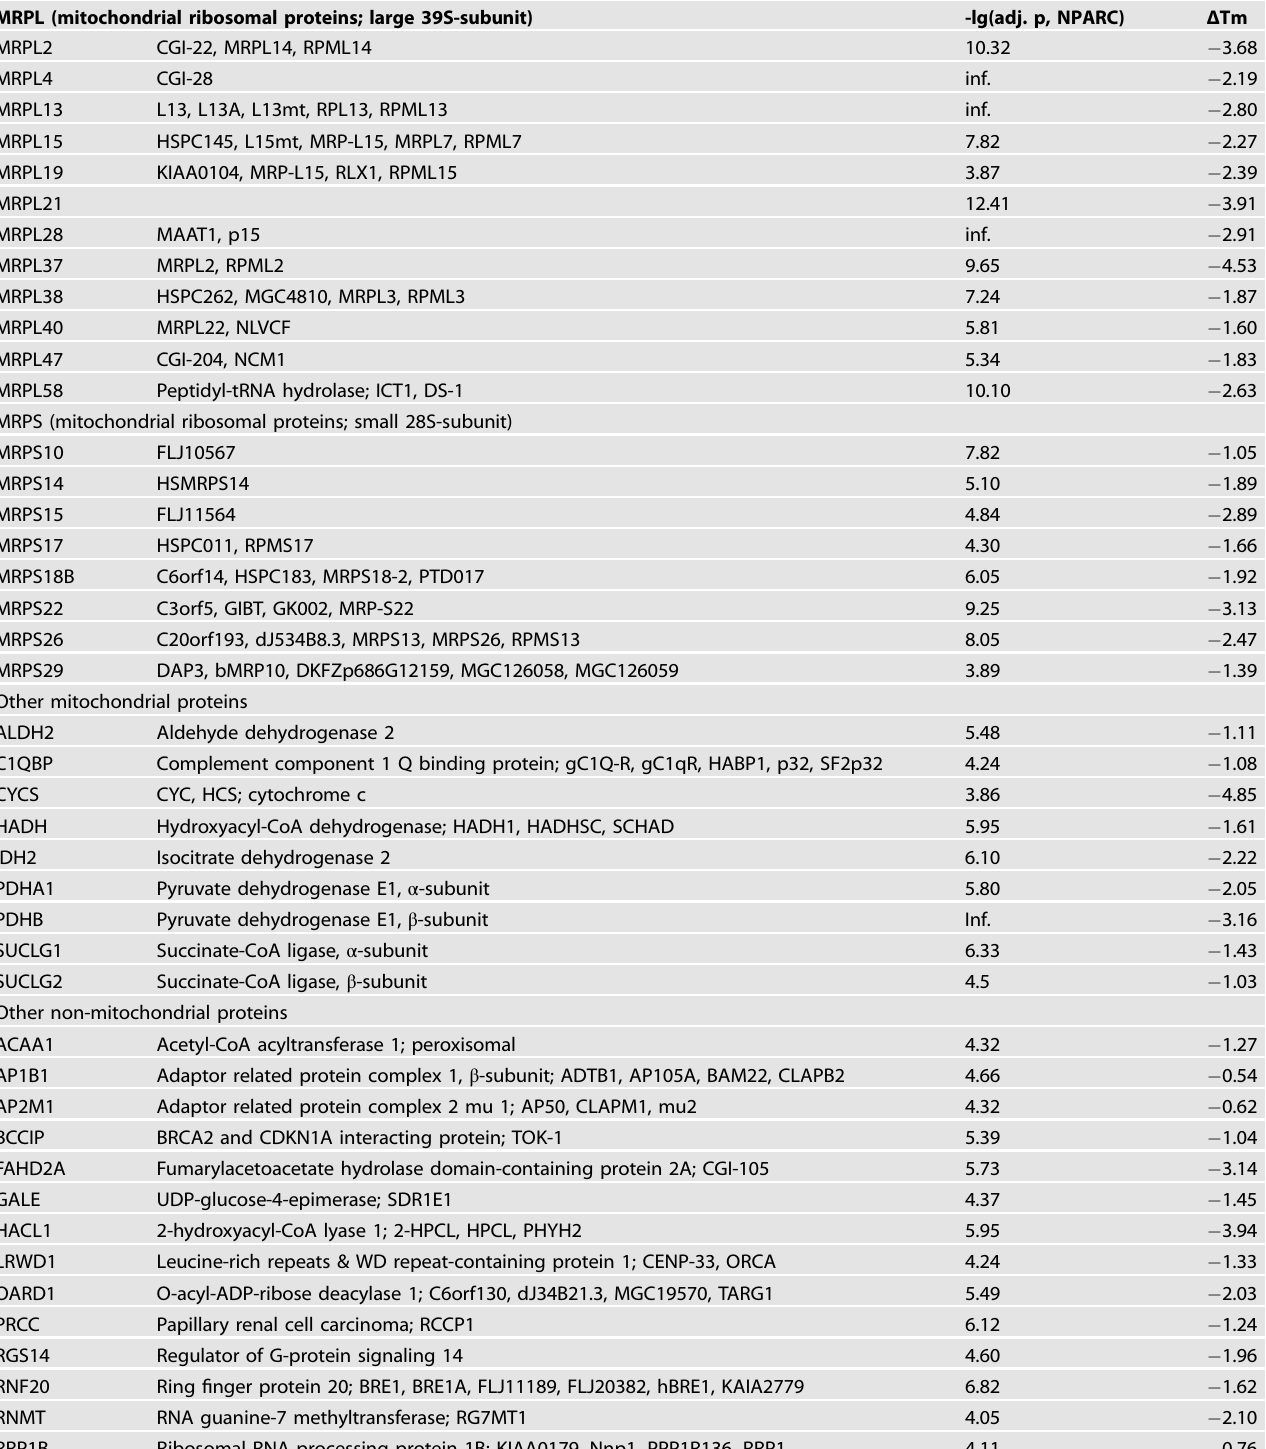
Table 1. List of proteins with reduced thermal stability upon VDT treatment. MRPL (mitochondrial ribosomal proteins; large 39S-subunit) -lg(adj. p,